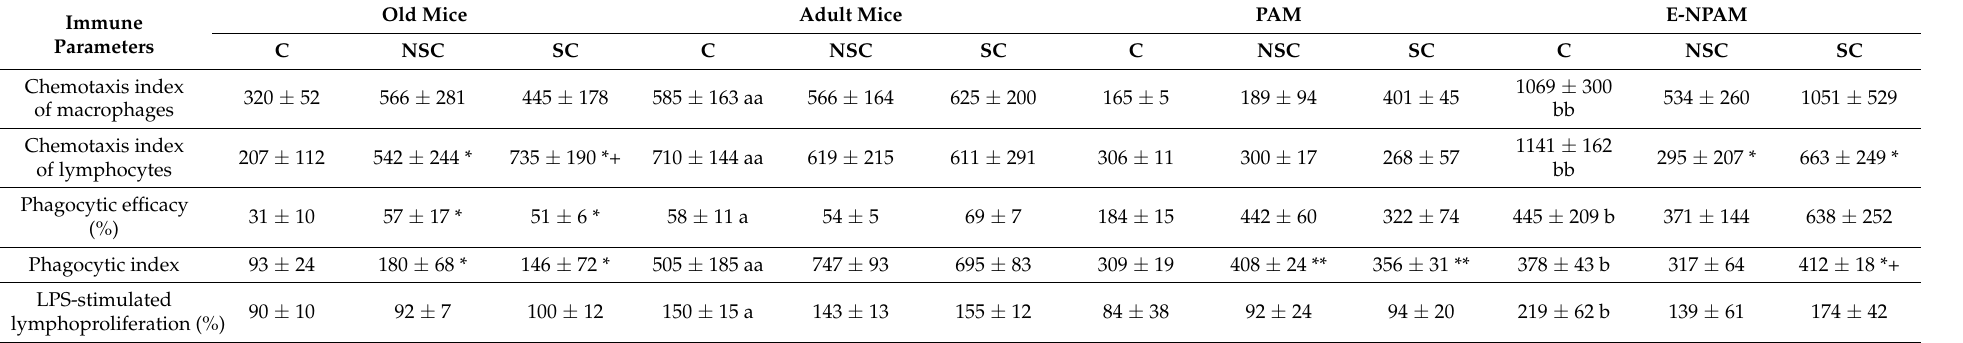
Each value represents the mean ± standard deviation of 6–15 values corresponding to the same number of animals. *: p < 0.05, **: p < 0.01 with respect to the values obtained in their corresponding control group. +: p < 0.05, with respect to the values obtained in the corresponding NSC group. After a statistical analysis comparing the means with the Student’s t-test for independent samples, significant differences were observed in the indicated experimental groups. a: p < 0.05, aa; p < 0.01 with respect to old mice C. b: p < 0.05, bb: p < 0.01 with respect to PAM C. C: control group (old mice/PAM: n = 6; adult